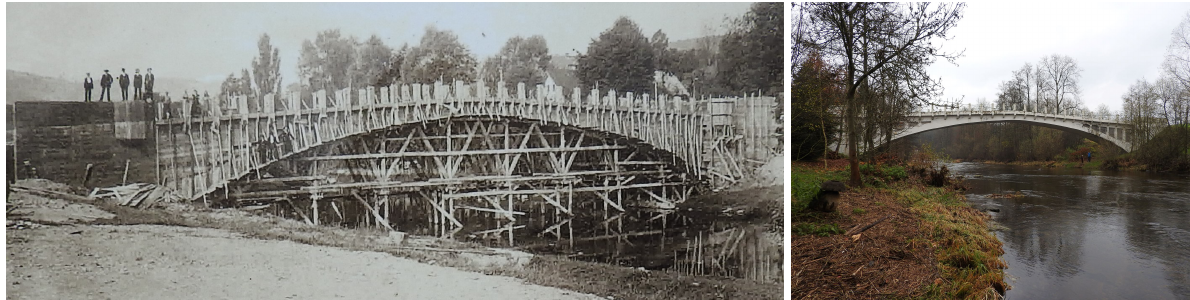
Figure 4. Vaulted bridge at Peřimov – Dolní Sytová, 1912 (left – during construction [5], right – at present).